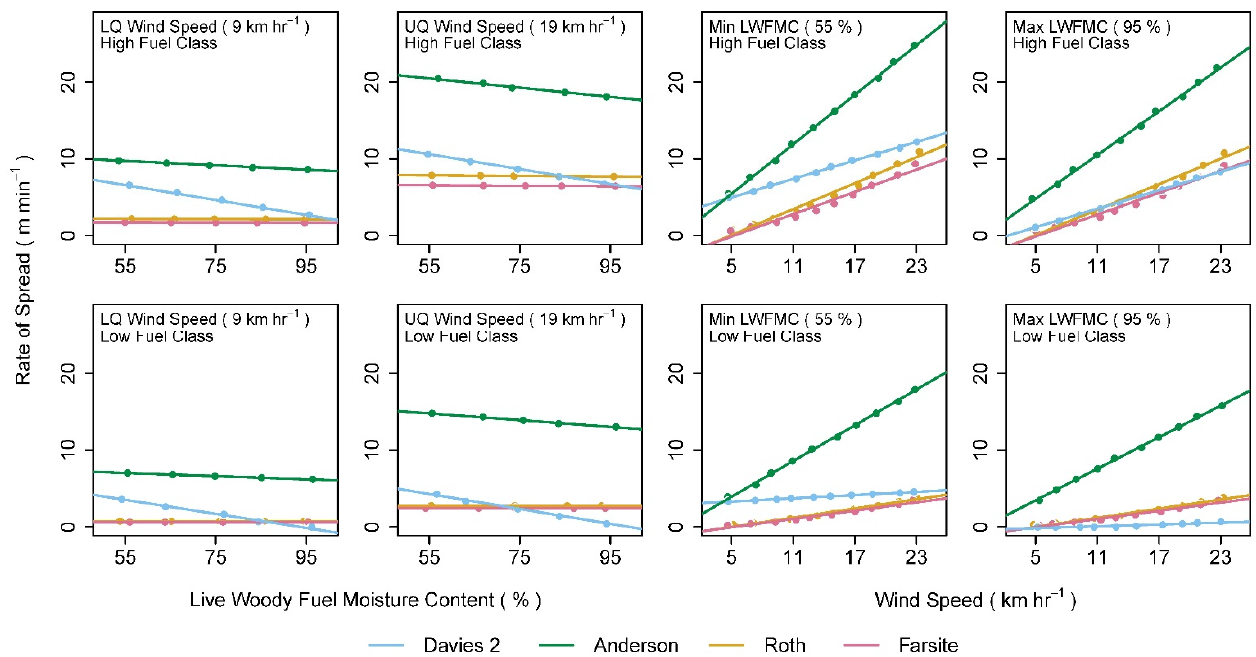
Figure 2. Sensitivity responses to changing fuel structural and fire weather inputs. High and Low fuel classes are aggregate fuel classes from Legg et al. [61]. Displayed fire behaviour models were selected to minimize clutter and overlaps. Full results are presented in the Supplementary Material (Table S5). Here, to gauge the interaction of fire weather parameters, lower (LQ) and upper quartiles (UQ) of wind speed were selected as constants to compare the effects of changing live woody (LW) fuel moisture contents (FMC) on the predicted rates of spread. Because a smaller effect on the rate of spread by live woody FMC was recorded, minimum and maximum values were selected for live woody FMC to compare the effects of changing wind speeds on the predicted rates of spread. A jitter was applied on the x -axis for clarity.